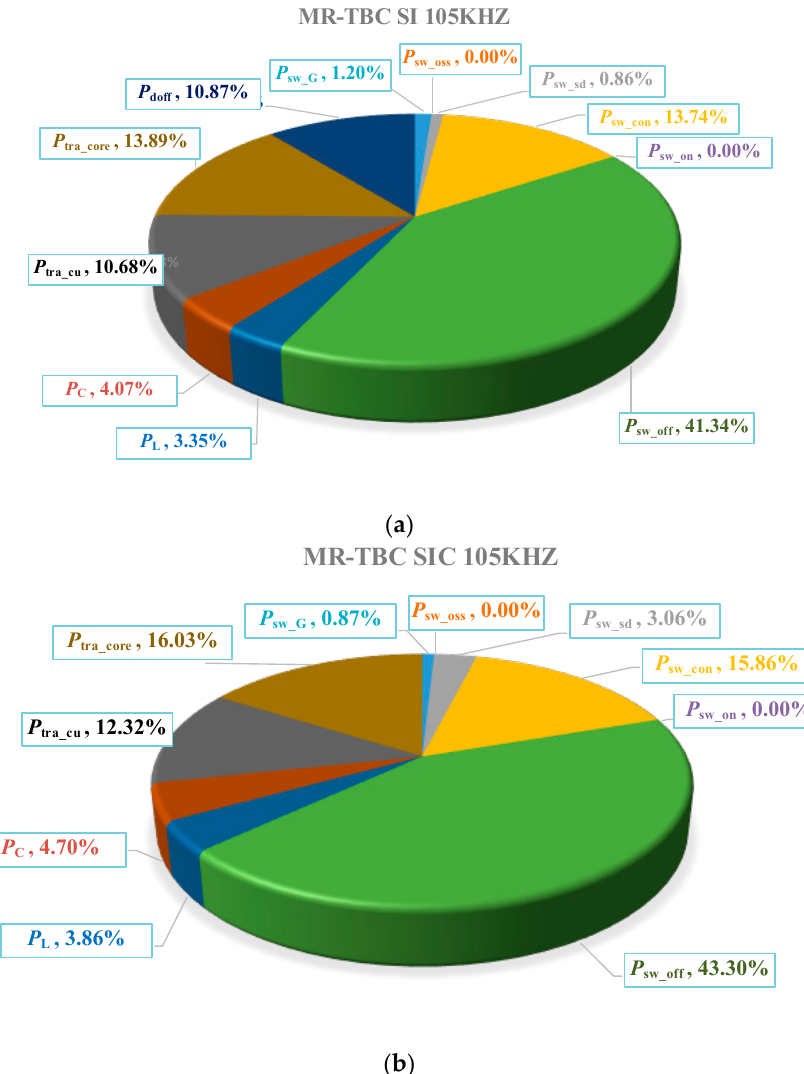
Figure 9. Loss distribution comparison between Si and SiC under 1500 W ( a ) Si; ( b ) SiC.